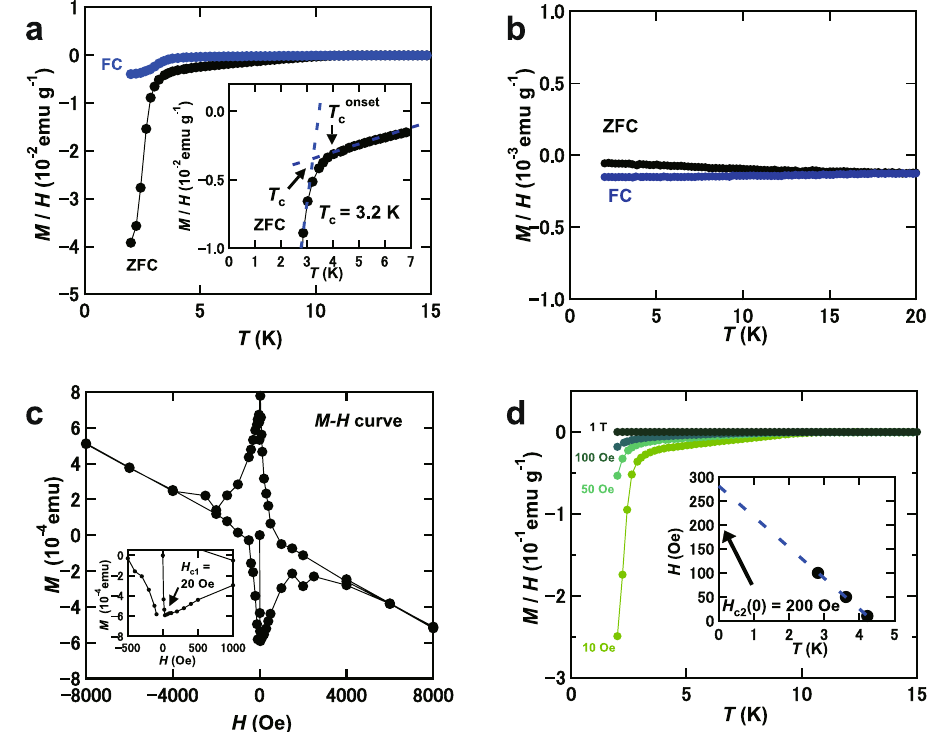
Figure 1. ( a ) M / H – T plots in ZFC and FC modes for Ca 0.8 Sr 0.2 C y . ( b ) M / H – T plot in ZFC and FC modes for SrC 6 . ( c ) M – H plot at 2 K for Ca 0.8 Sr 0.2 C y . ( d ) M / H - T plots at different H’ s for Ca 0.8 Sr 0.2 C y , measured in ZFC mode. Inset of ( a ) shows how to determine the T c . The inset of Fig. 1(c) shows the M – H plot in the low- H range. Inset of ( d ): H c2 – T plot for Ca 0.8 Sr 0.2 C y determined from ( d ). Stoichiometry of Ca 0.8 Sr 0.2 C y refers to the experimental nominal value, and all samples were made by the intercalation of Ca and Sr in